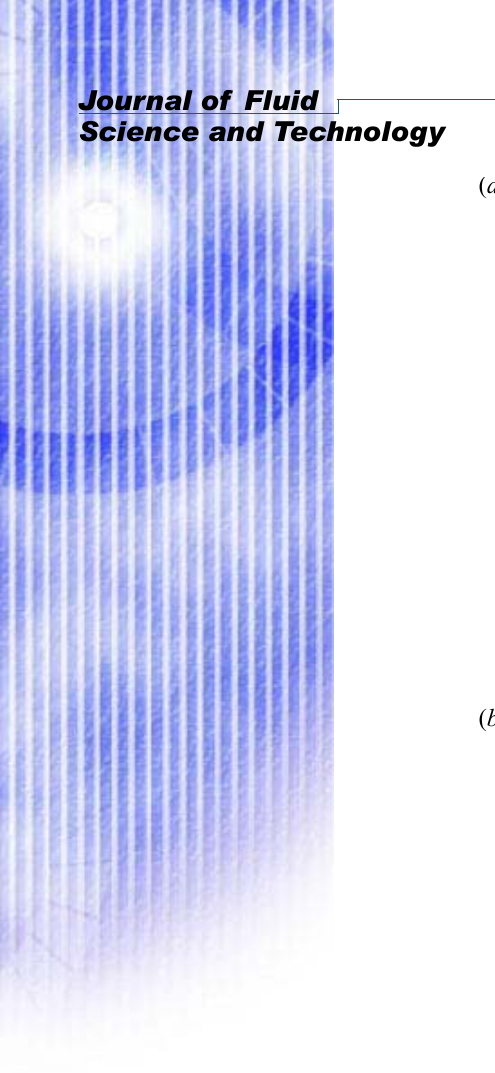
fluorescein. The electroosmotic mobility was calculated by the elelctoosmotic flow velocity divided by an electric field of 37 V/cm. In the microchannel without the CMNB-caged fluorescein, the electroosmotic mobilities of the borosilicate glass and PDMS walls are estimated at 5.16 × 10 − 8 m 2 /(V ⋅ s) (this value gives the zeta-potential of − 66.2 mV) and 4.93 × 10 − 8 m 2 /(V ⋅ s) ( − 63.3 mV), respectively, which are in reasonable agreement with the values of 5.6 × 10 − 8 m 2 /(V ⋅ s) and 4.3 × 10 − 8 m 2 /(V ⋅ s) reported by Ross and Locascio (17) . On the other hand, for the microchannel rinsed by the CMNB-caged fluorescein, the electroosmotic mobility of the PDMS wall shows larger, so that the velocity gradient was formed in the depthwise ( Z -) direction. According to the reports by Ross and Locascio (17) , the electroosmotic mobility (or the zeta-potential) of the glass wall was smaller than that of the PDMS wall, when the both walls were rinsed by a solution including the caged fluorescent dye. An understanding deduced from the results by the present study and Ross and Locascio (17) is that EWMT can capture the velocity field near the glass wall, while MT by volume illumination may capture the velocity field affected by the zeta-potential of the PDMS wall.